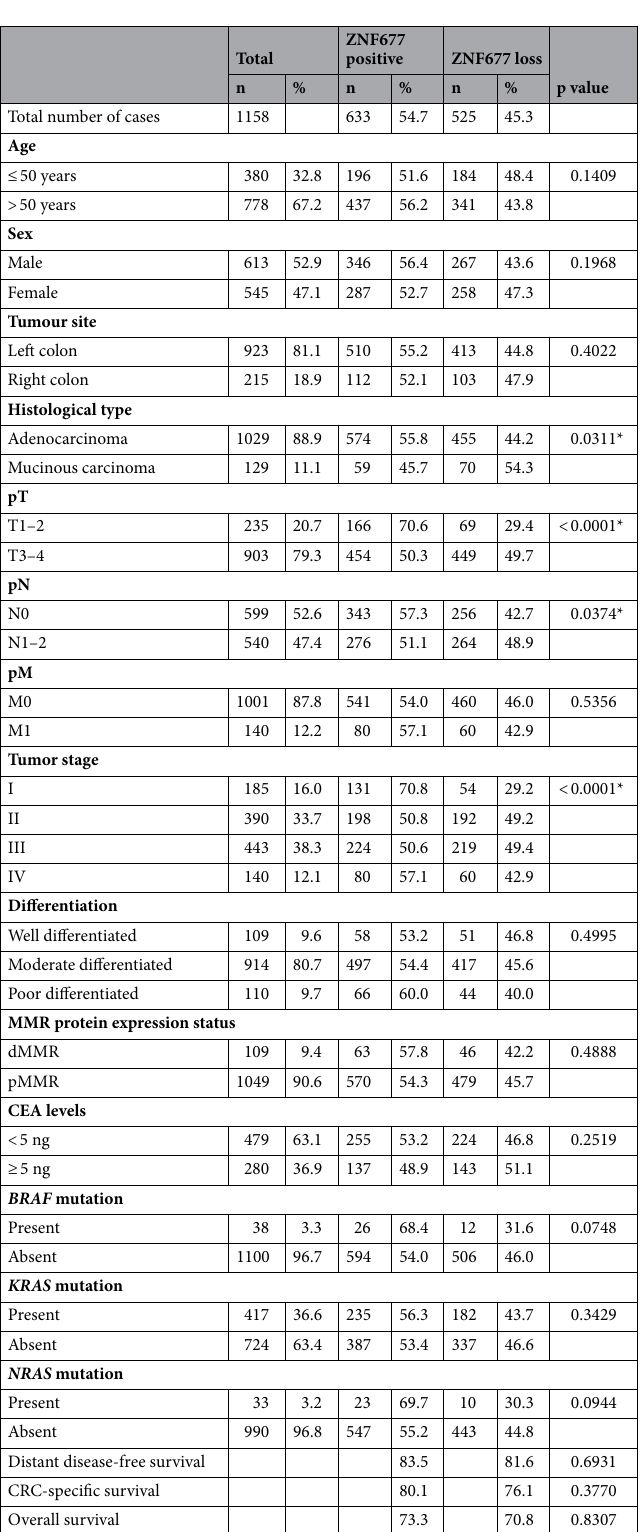
Table 2. Correlation of ZNF677 immunohistochemistry expression with clinico-pathological parameters in colorectal carcinoma. *Significant p